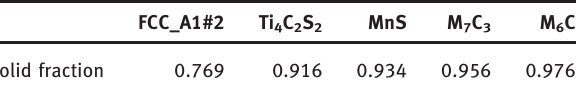
Table 2: Solid fraction of precipitation.